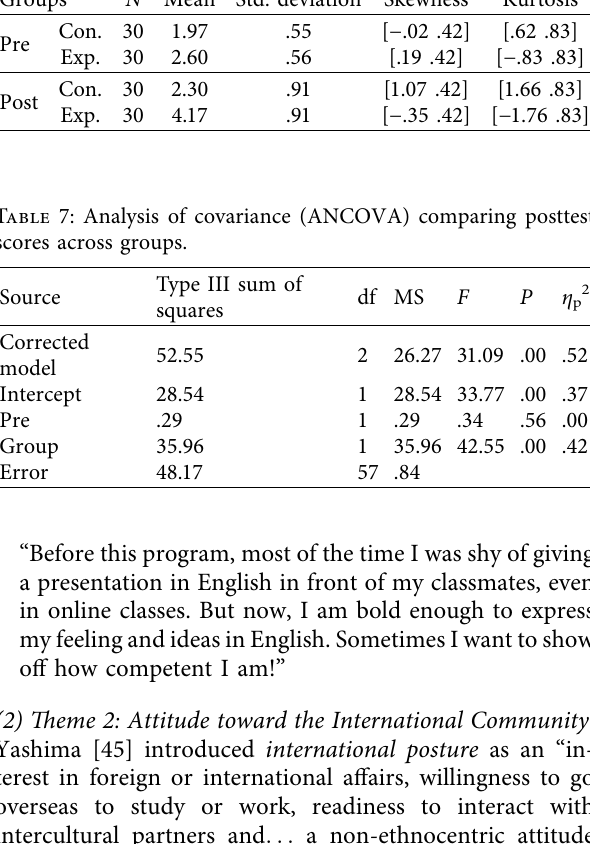
Table 6: Descriptive statistics for both groups in two-time points. Groups